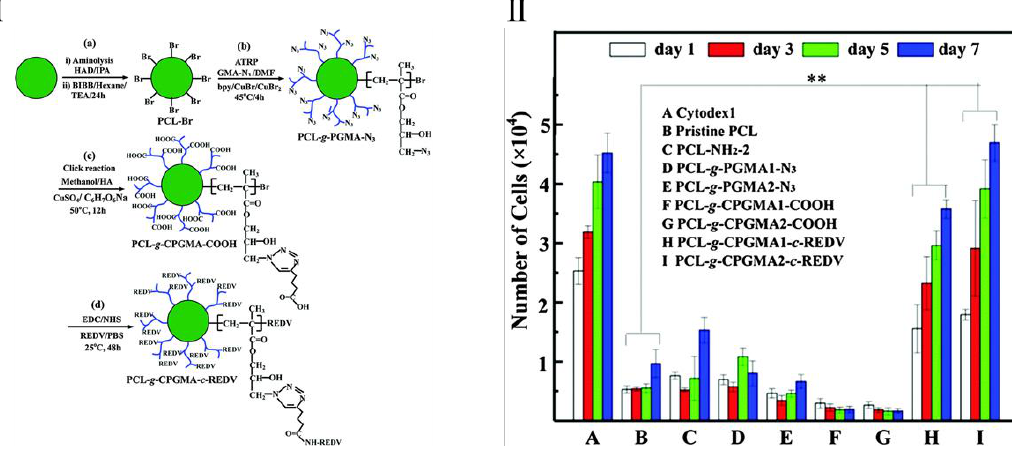
Figure 7. Schematic representation of the chemical reactions performed for the incorporation of REDV onto the surface of poly(ε-caprolactone) (PCL) microparticles ( I ). Microparticles are first aminolyzed and then the atom-transfer radical-polymerization (ATRP) initiator (α-bromoisobutyl bromide: BIBB) is incorporated ( a ); then, azido-terminated poly(glycidyl methacrylate) (PGMA) polymer brushes are grown via surface-initiated ATRP ( b ); the brushes are further carboxylated via the azide-alkyne click reaction ( c ), and, finally, REDV is incorporated via carbodiimide chemistry ( d ). The number of cells clearly increased after the incorporation of REDV in comparison to pristine PCL microparticles ( II ). ** indicates significant differences (p<0.01). Reproduced from Ref [79] with permission from The Royal Society of Chemistry, 2015.